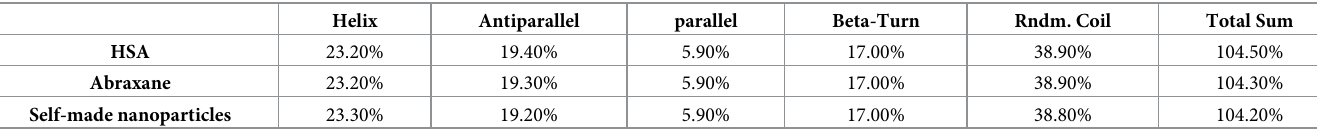
Table 2. Secondary structure composition and assignments for HSA obtained from CD